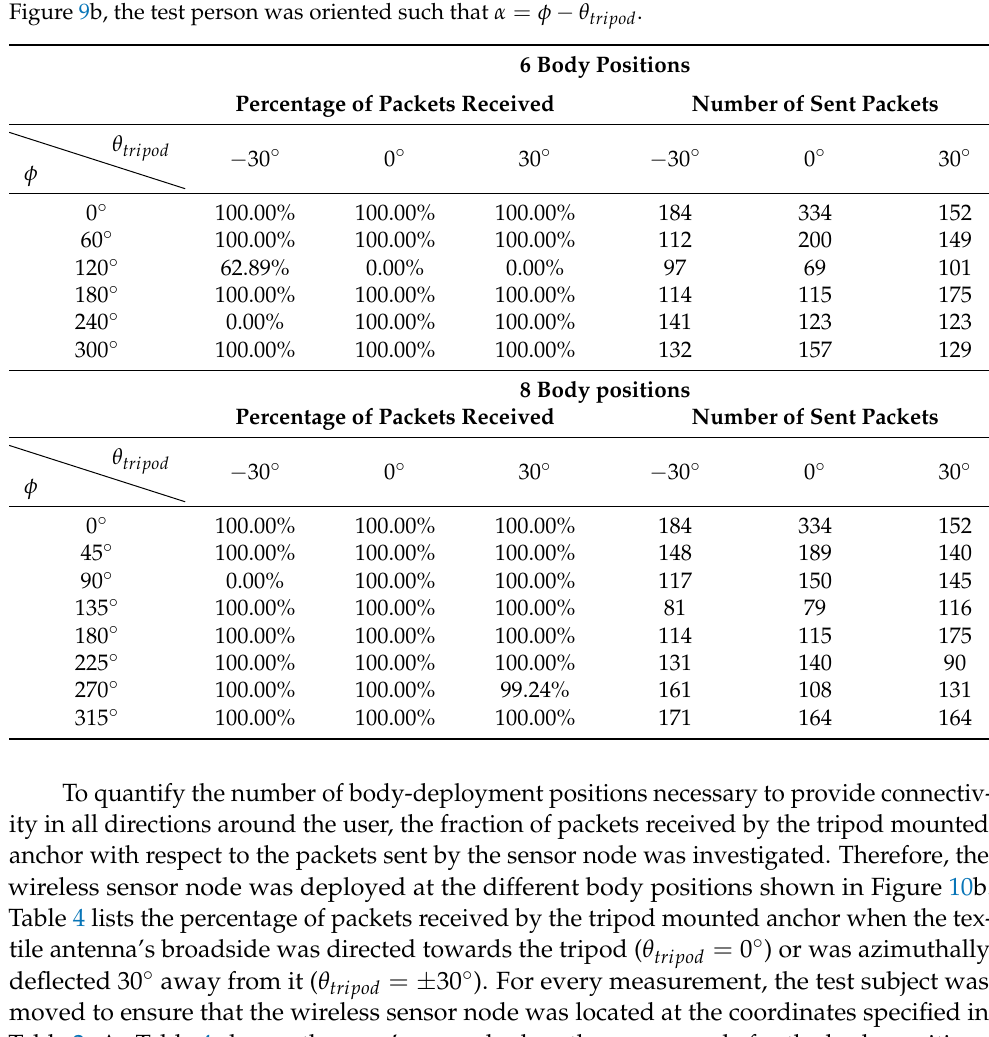
Table 4. Percentage of packets received by the anchor on the fixed tripod mount for different body- deployment positions characterized by φ and for different deflections θ tripod between the textile antenna’s broadside orientation with respect to the direction of the tripod mount. As visualized in Figure 9b, the test person was oriented such that α = φ − θ tripod